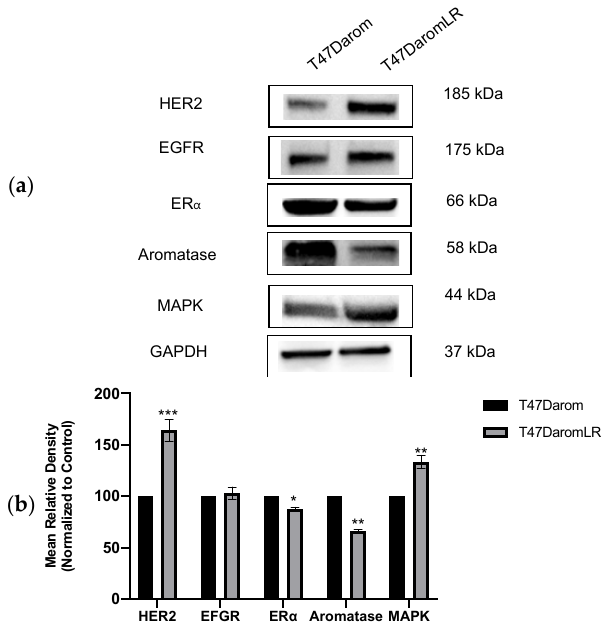
Figure 2. Comparative protein expression profile of letrozole-sensitive cells (T47Darom) versus letrozole-resistant cells (T47DaromLR). ( a ) The T47Darom and the T47DaromLR cells were assayed by immunoblot with antibodies directed against HER2, EGFR, ER α , aromatase, and MAPK. GAPDH was measured as an internal loading control. ( b ) Quantitative analysis representing the fold changes of the indicated proteins after normalizing to GAPDH loading control. The T47Darom cells were set to 100%. Student’s t ‐ tests were performed, and treatments were compared to DMSO control. Results are expressed as the mean unit ± SD (*** p < 0.001, ** p < 0.01, * p < 0.05), and data are representative from one of at least three independent experiments.